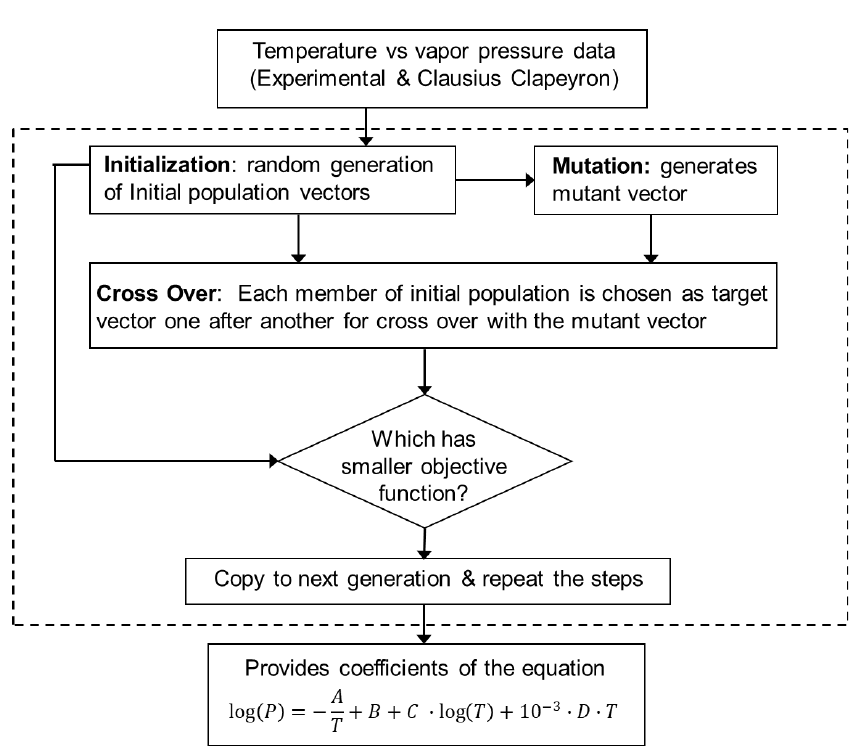
Figure 1. The overall structure of this work. Data collected from experimental work and synthesized using the Clausius Clapeyron equation is fed to a differential evolution genetic algorithm (GA) to provide the coefficients A , B , C , and D of the vapor pressure relation. The dotted box indicates the GA algorithm.